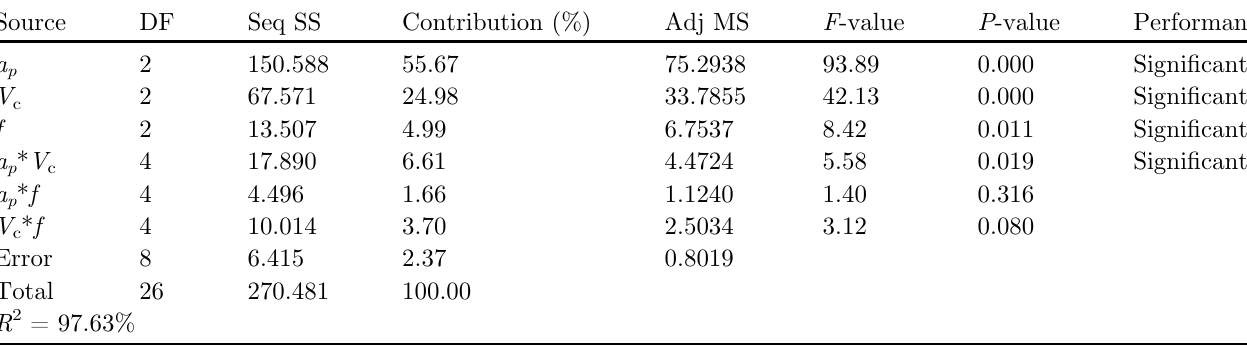
Table 7. Analysis of variance results for power consumption (UT).